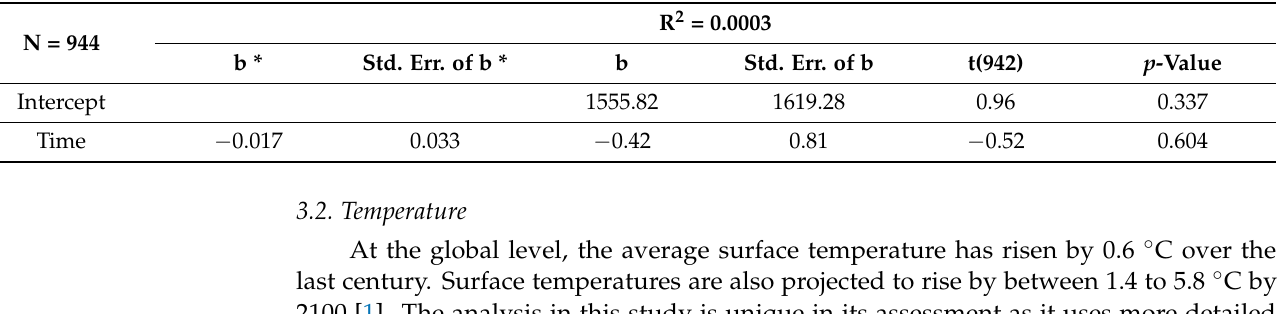
Table 2. Statistical regression analysis for annual rainfall in the Mopani and Vhembe districts. N = 944 b * Std. Err. of b * b Time − 0.017